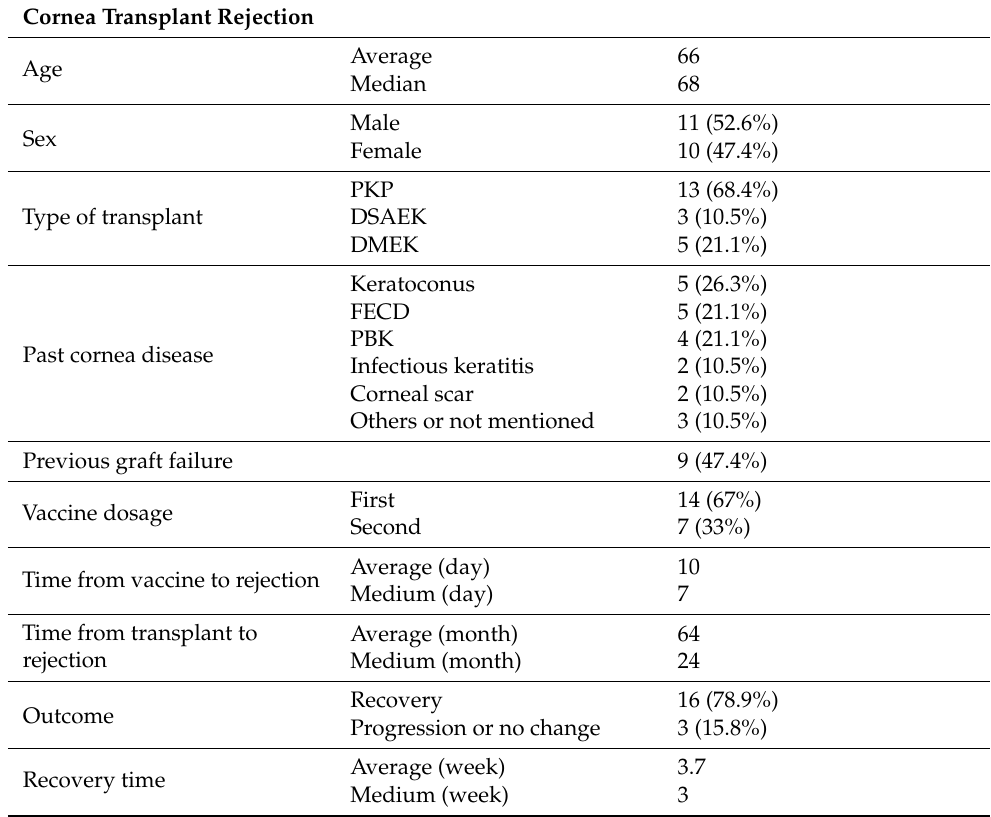
Table 3. Summary of cornea transplant rejection